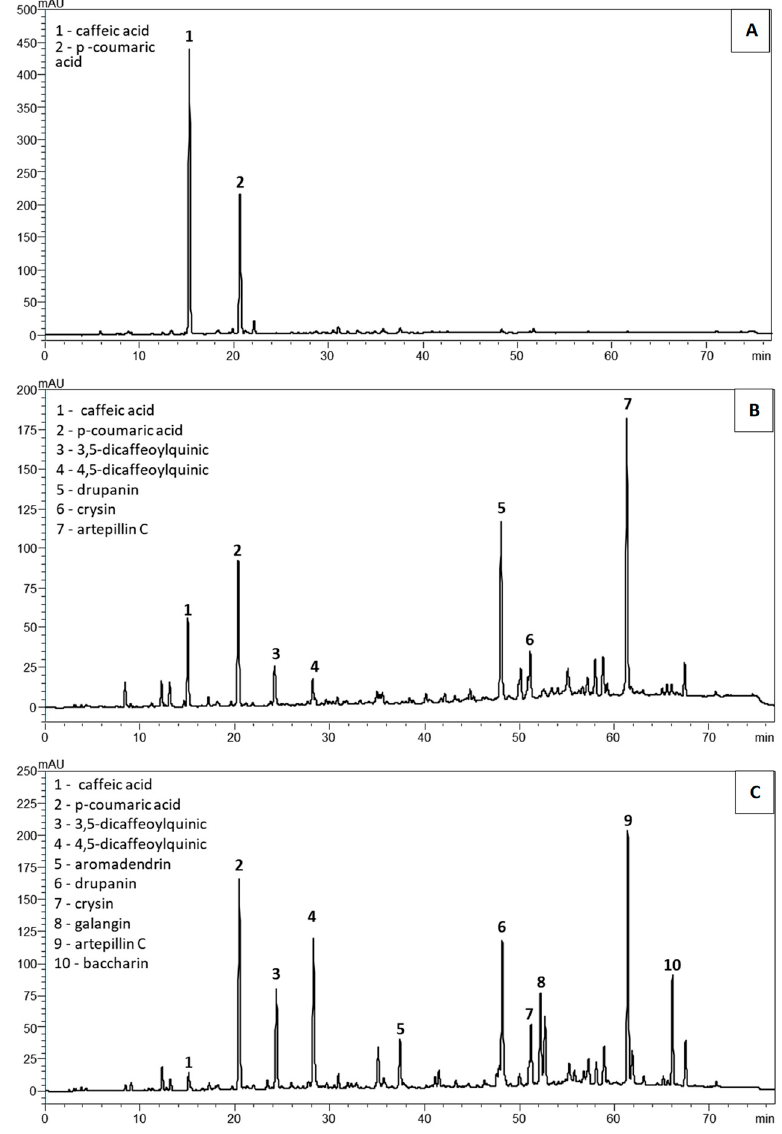
Figure 3. Chromatographic fingerprint of the propolis samples: ( A ) polar propolis fraction (PPF); ( B ) propolis soluble dry extract (PSDE); ( C ) microencapsulated propolis extract (MPE), prepared according to [6]. HPLC analysis was run with a C18 reversed-phase column coupled to a pre-column, with a mobile phase of methanol and an aqueous solution of formic acid (0.1% v / v ), pH 2.7. The method consisted of a 20–95% gradient for 77 min at a flow rate of 0.8 mL/min in a CLC-ODS column (4.6 mm × 250 mm, particle diameter 5 µm, pore diameter 100 A). Detection was set at 275 nm.